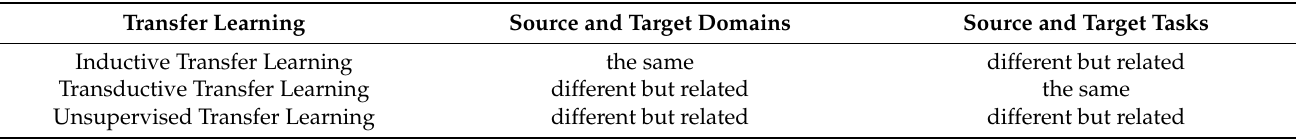
Table 1. The definition of transfer